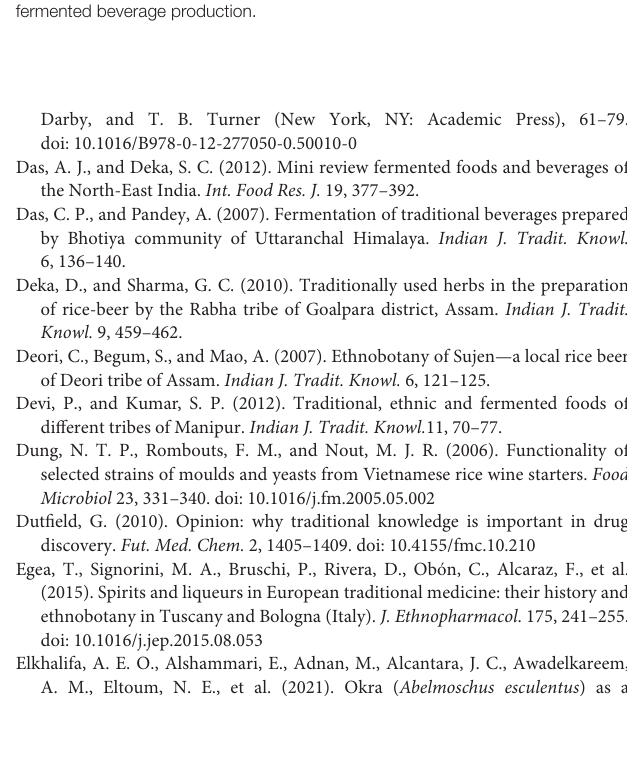
Supplementary Figure 1 | Percentage of various cereals used by the tribal communities for the preparation of alcoholic beverages. Supplementary Figure 2 | Schematic diagram depicting different stages of fermented beverage